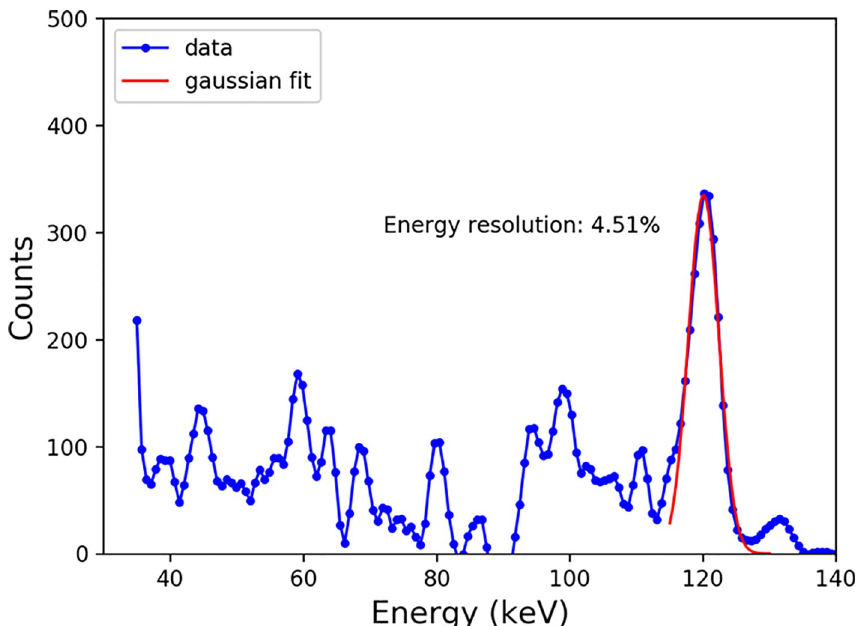
Fig 9. The energy spectrum of the CdTe detector with FWHM of 4.51% at 122.06 keV.